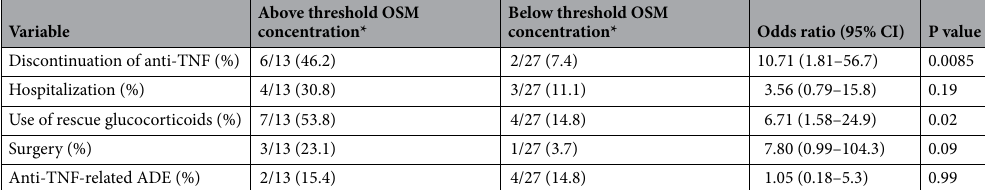
Table 3. Incidence of secondary outcomes in participants with ulcerative colitis. Oncostatin-M, OSM; confidence interval, CI; tumor necrosis factor-α, TNF; adverse drug event. *Threshold OSM concentration in ulcerative colitis is defined as 233.6